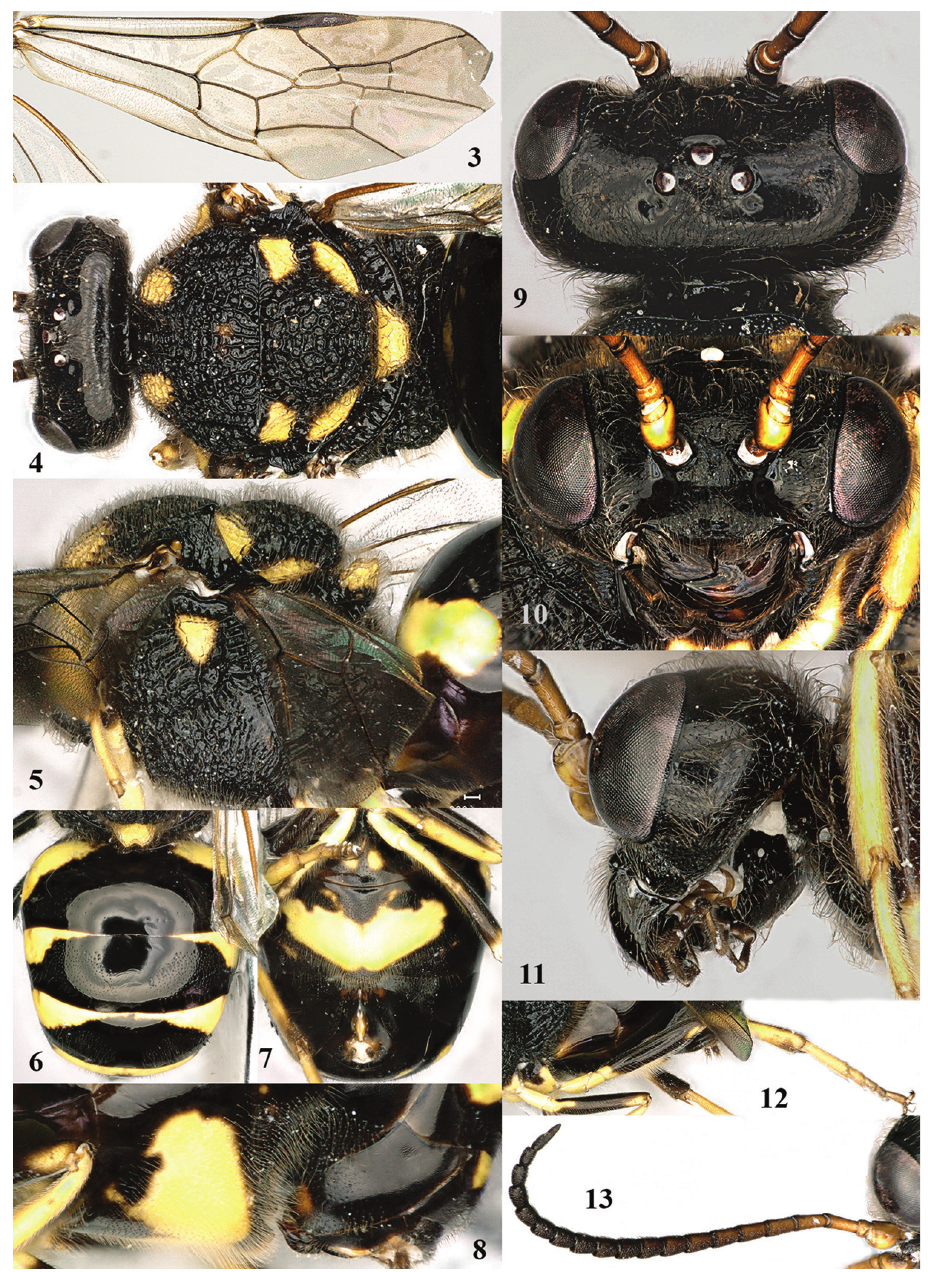
Figures 3–13. Bareogonalos xibeidai sp. n., female, holotype. 3 fore wing 4 head and mesosoma dorsal 5 mesosoma lateral 6 metasoma dorsal 7 metasoma ventral 8 detail of second and third sternites lateral 9 head dorsal 10 head anterior 11 head lateral 12 hind leg lateral 13 antenna